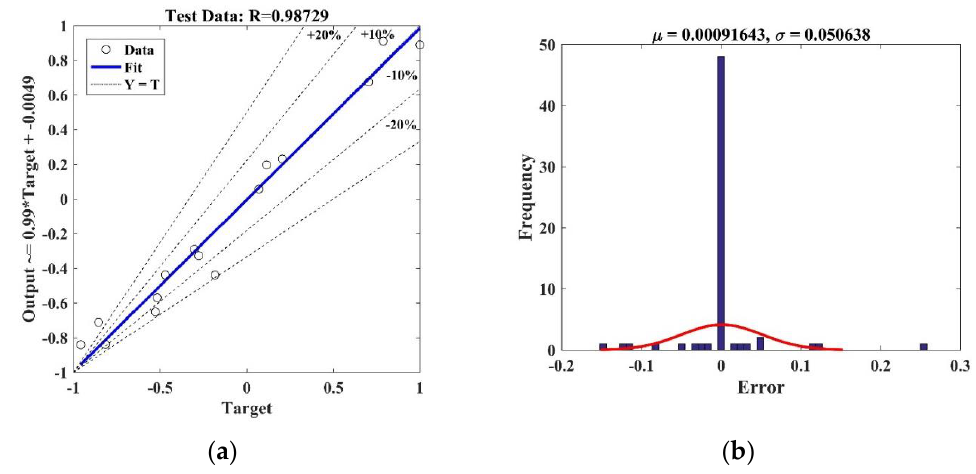
Figure 4. UCS prediction precision and error histogram using SVR: ( a ) correlation coefficient and ( b ) error histogram.